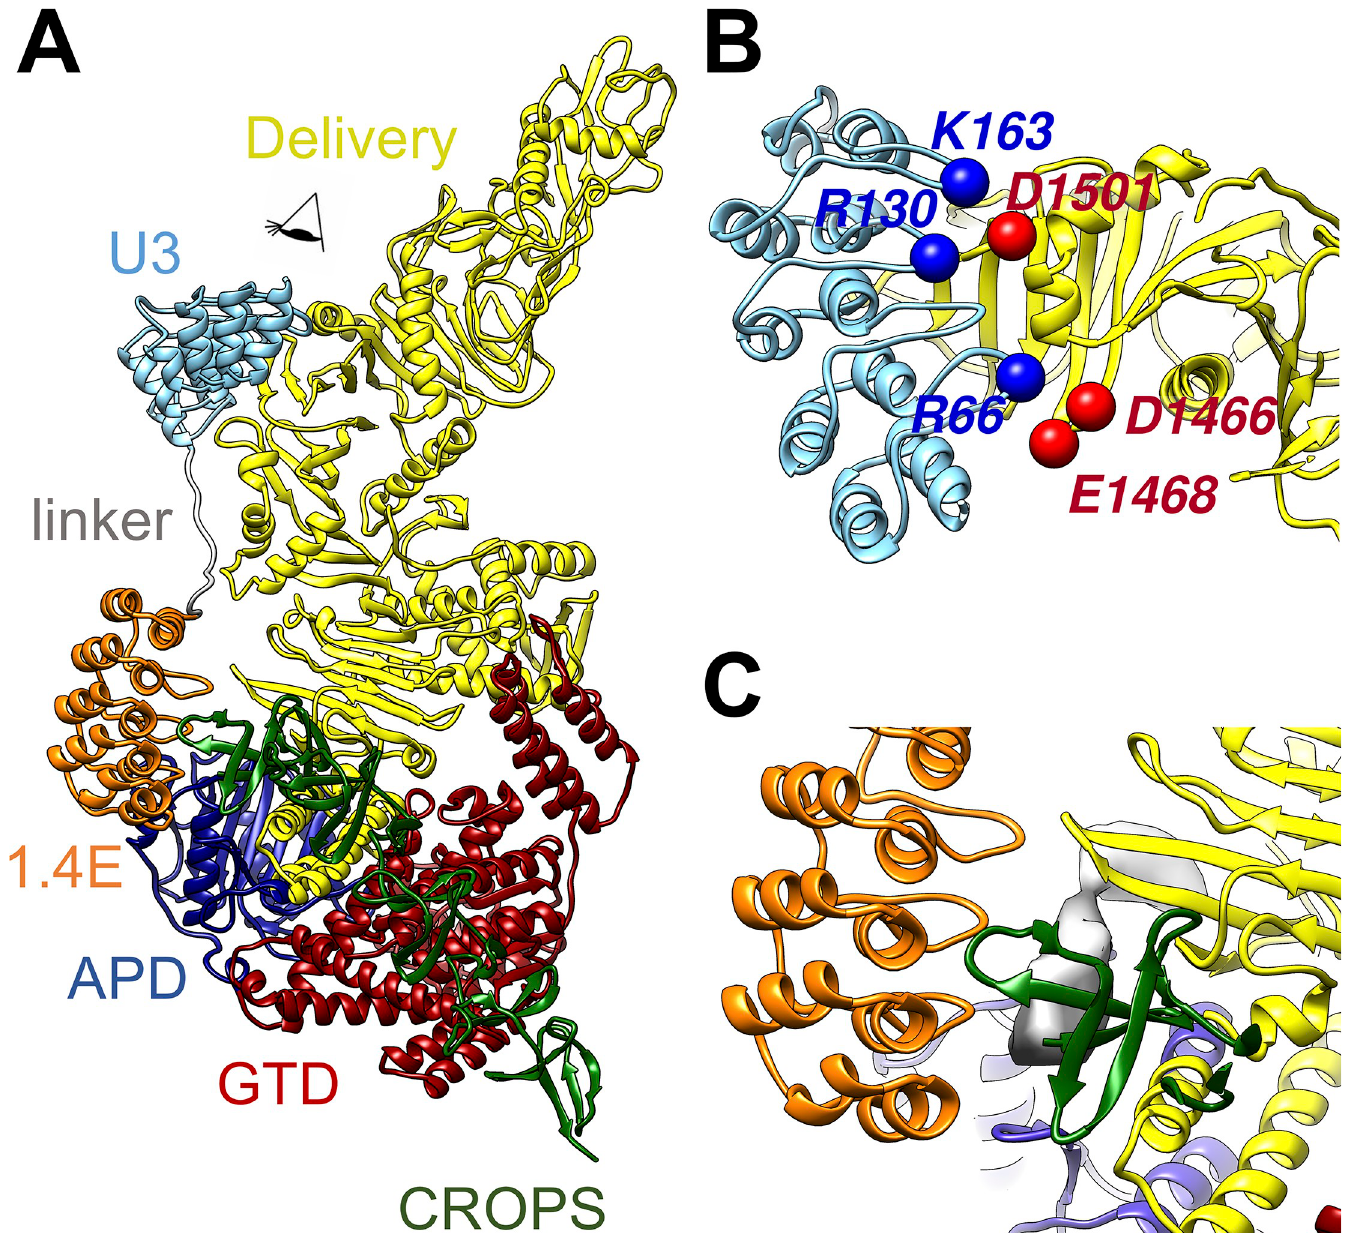
Fig 8. Interactions between TcdB and DLD-4. (A) Overall model of the complex. (B) Zoom-in view to show the interactions between U3 DARPin and TcdB as viewed in the direction labeled by an eye cartoon in Panel A. (C) Zoom-in view to show the interactions between the DARPin 1.4E and TcdB at the region as labeled by red dashed box in Panel A. APD, autoprocessing domain; CROPS, combined repetitive oligopeptides; DARPin, designed ankyrin repeat protein; GTD, glucosyltransferase domain; TcdB, C . difficile toxin B.